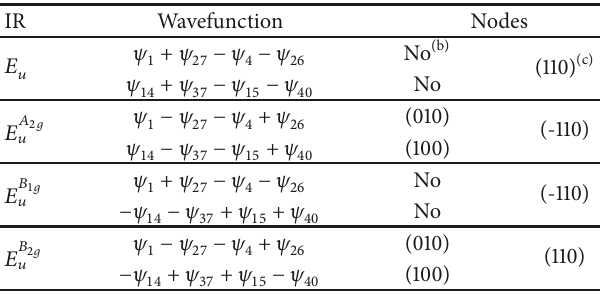
Figure 3: Basis set for Cooper in a general point of a BZ ( 𝐷 4ℎ symmetry). Basis function 𝜓 1 is defined by formula (28), whereone- electron wavevector 𝑘 1 runs over basis domain of BZ and dashed lines correspond to wavevectors 𝐼𝑘 𝑖 . Basis function 𝜓 𝑖 is obtained by the action of point group element ℎ 𝑖 on 𝜓 1 (notations in [26] are used; also see text). Table 8: Spatial parts of triplet wavefunctions for IR 𝐸 𝑢 of 𝐷 4ℎ group in 𝑥 - 𝑦 form ( a ) . Basis function 𝜓 1 corresponds to arbitrary wave vector 𝑘 1 in a Brillouin zone in one-electron space and is built according to formula (28) (superscript 𝑡 is dropped). Other basis functions are obtained by the action of half of the elements of group 𝐷 𝜓 4ℎ on 1 (see Figure